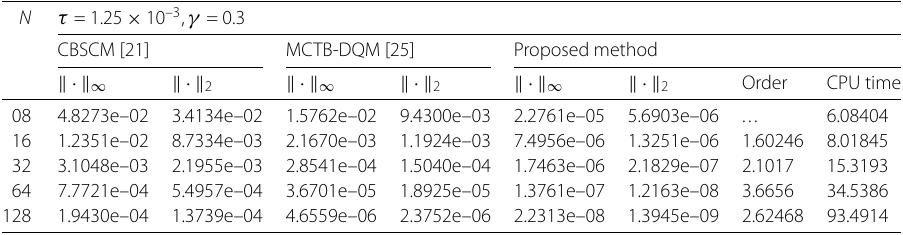
Table 5 A comparison of maximum error ( (cid:10) · (cid:10) ∞ ) and Euclidean norm ( (cid:10) · (cid:10) 2 ) at T = 1 for problem-2 N τ = 1.25 × 10 –3 , γ =